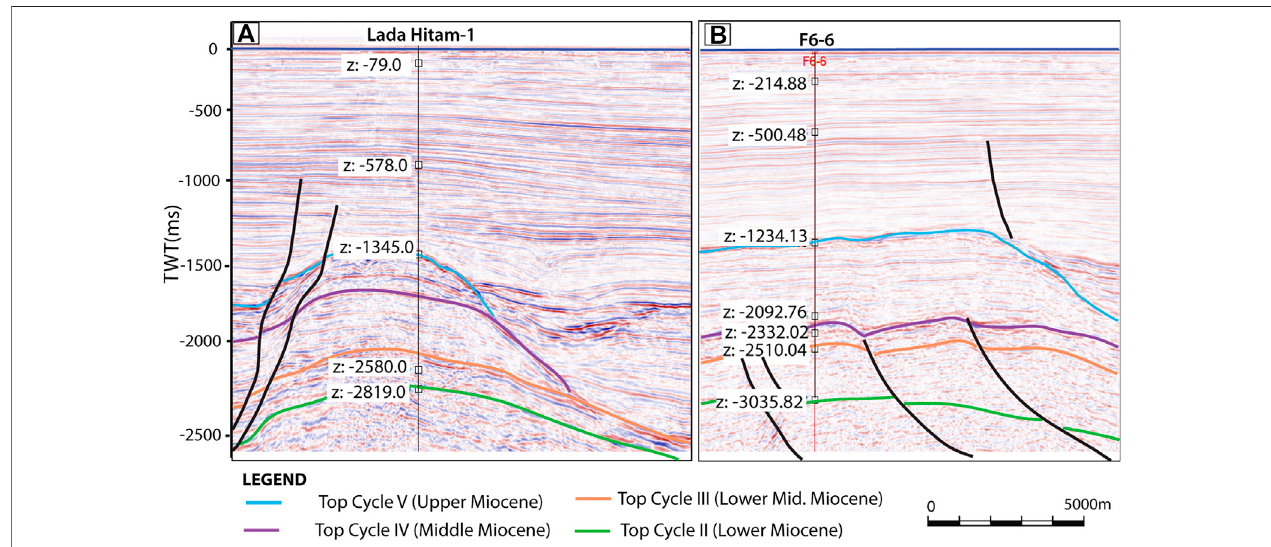
FIGURE 3 | Seismic and well correlation for time-depth conversion for Lada Hitam-1 and F6-6 wells in the central part of Luconia Province provide con fi dence in interpretation of the seismic data. The depth values (Z) for both wells are labelled with corresponding interpreted seismic horizons.